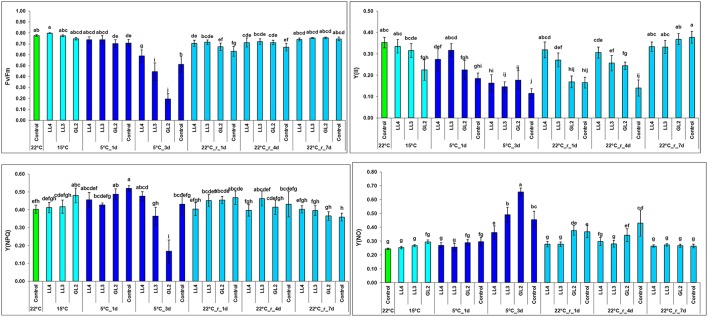
Effect of cold hardening in maize at 15°C under different light conditions, followed by chilling stress at 5°C and 7-d recovery on the chlorophyll-a fluorescence induction parameters Fv/Fm, Y(II) (the quantum yield of Photosystem 2 estimated as ΔF/Fm′), Y(NPQ) and Y(NO) (the regulated and non-regulated non-photochemical quenching). Different letters on the bars represent statistically significant differences at p < 0.05.